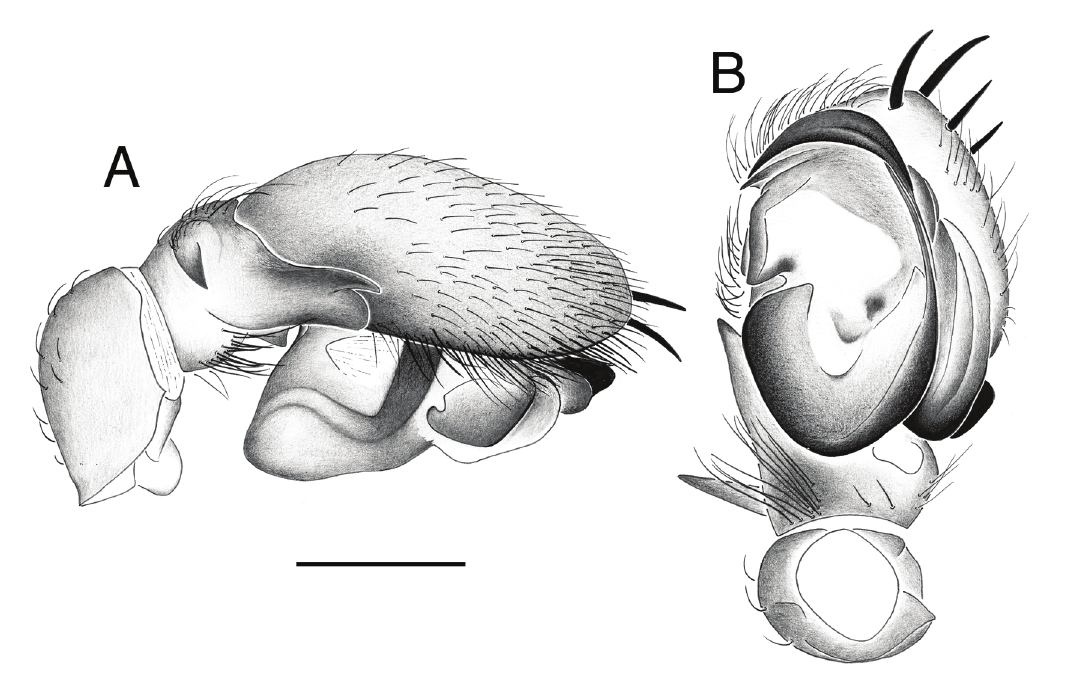
Fig. 13. Palindroma obmoimiombo gen. et sp. nov., holotype, ♂ (MRAC 241633). A . Palp, retrolateral view. B . Idem, dorsal view. Scale bars = 0.5